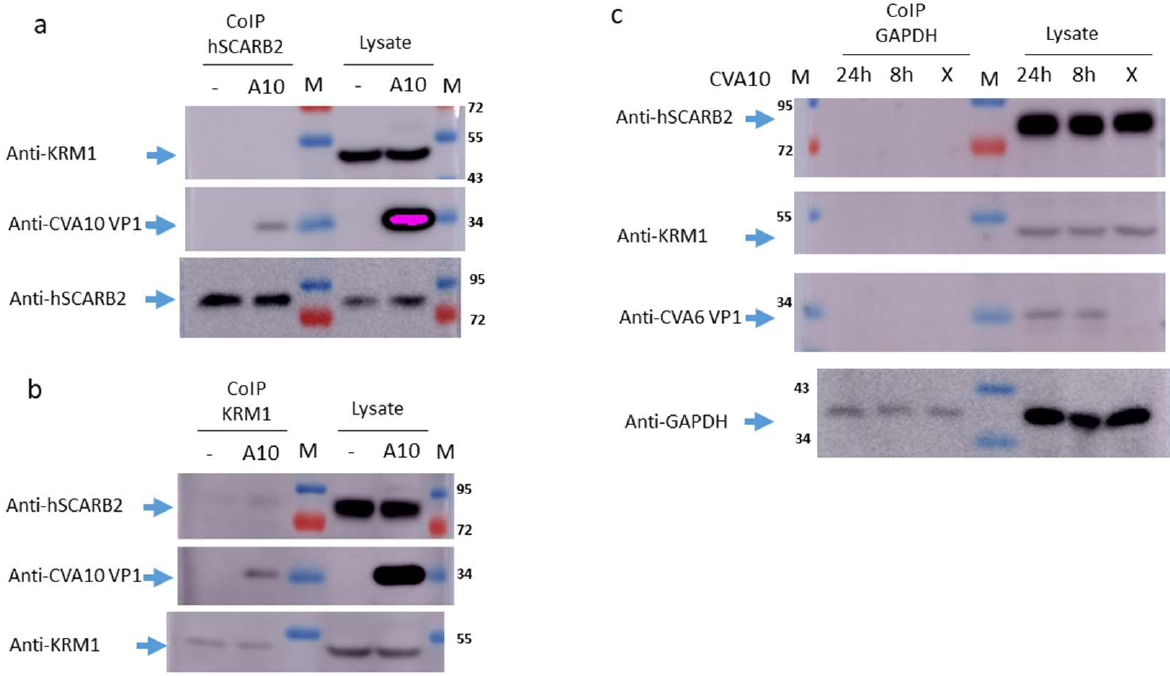
Figure 2. Association of hSCARB2 with KRM1 in CVA10-infected RD cells. RD cells were inoculated with MOI = 0.1 of CVA10 and cultured for 8 and 24 h before lysate preparation. Uninfected RD cells were cultured in parallel. Next, 50 µg cell lysates were prepared and mixed with the magnetic bead- conjugated antibody against ( a ) hSCARB2, ( b ) KRM1, and ( c ) isotypic antibody specific to GAPDH, individually, for immunoprecipitation (CoIP). The co-precipitates were subjected to Western blot against associated hSCARB2, CVA10 VP1, and KRM1 proteins. Lysates (20 µg) from infected and uninfected RD cells were directly subjected to immunoblot to detect the investigated proteins.